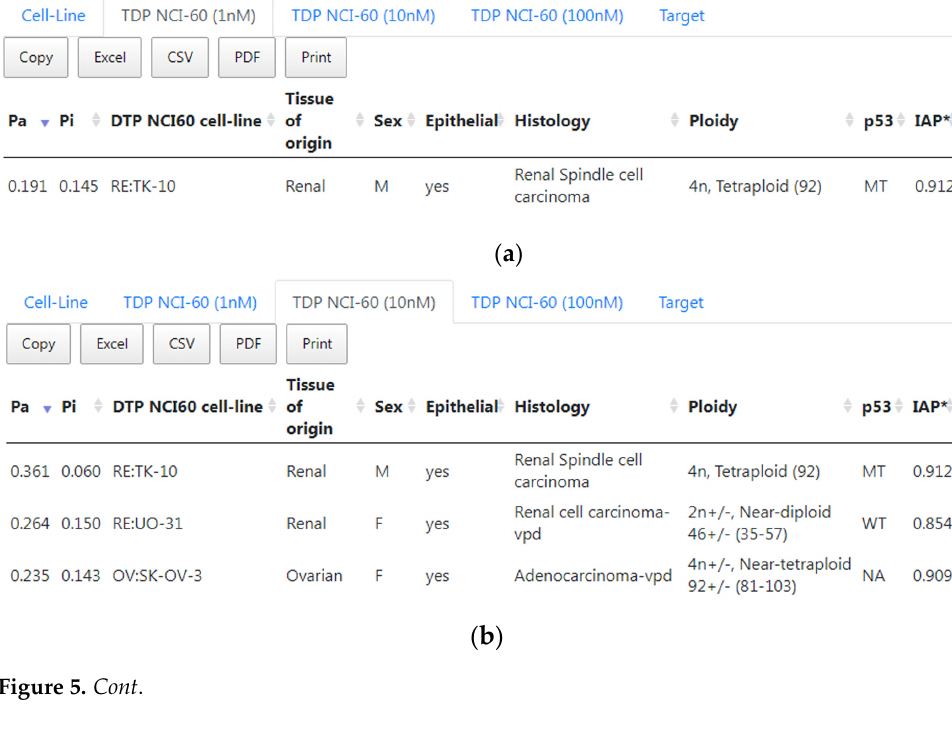
( c ) Figure 5. CLC-Pred 2.0 results of cytotoxicity prediction based on the TDP’s NCI60 data for erlotinib at different threshold of cytotoxicity: ( a ) at 1 nM, ( b ) at 10 nM; ( c ) at 100 nM. The prediction results for possible molecular mechanisms of action include the pre- diction of EGFR antagonism, which is the main mechanism of the anticancer activity of erlotinib, as seen in Figure 6, wherein the value of the probability for erlotinib to be an EGFR antagonist is higher than the one for other predicted mechanisms of action. One can also see that erlotinib has a high probability to act as an inhibitor of several kinases. Such probability may become the basis for studying experimentally the interaction of erlotinib with the appropriate kinases. Figure 6. Interface of CLC-Pred 2.0 with prediction results of molecular mechanisms of action for erlotinib.